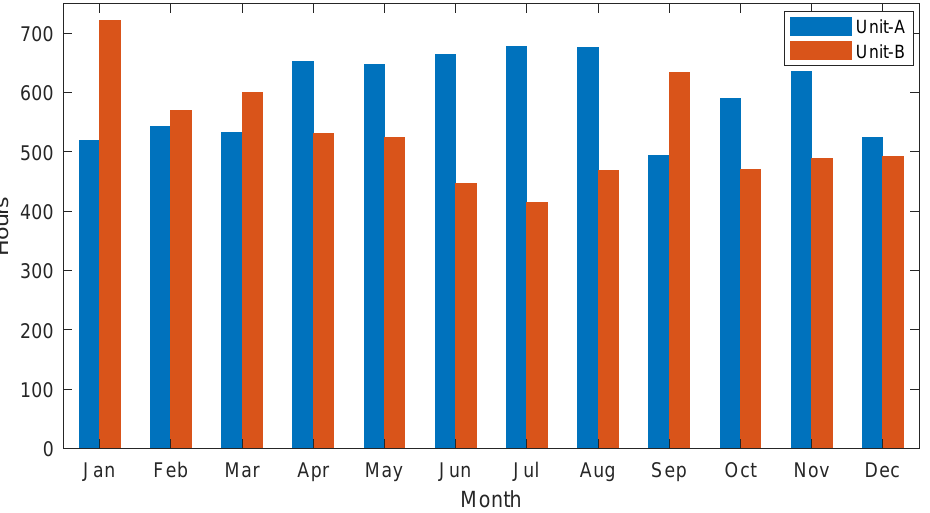
Figure 3. Monthly running hours (by unit).